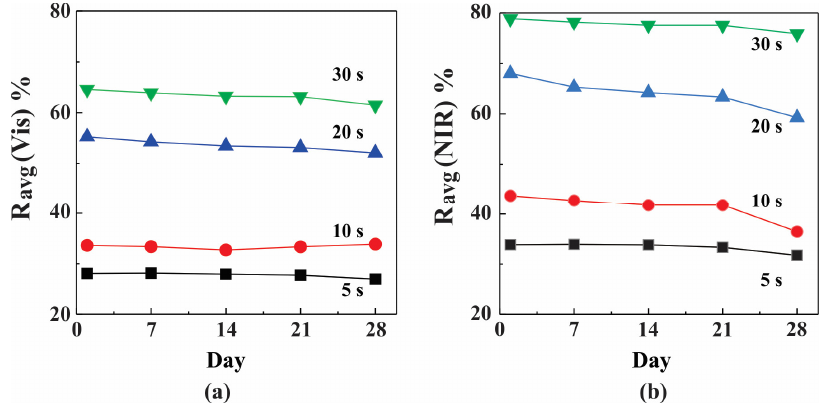
Figure 9. Variations of average reflectance in ( a ) Vis and ( b ) NIR ranges for the films after being kept in the air for 7 to 28 days.